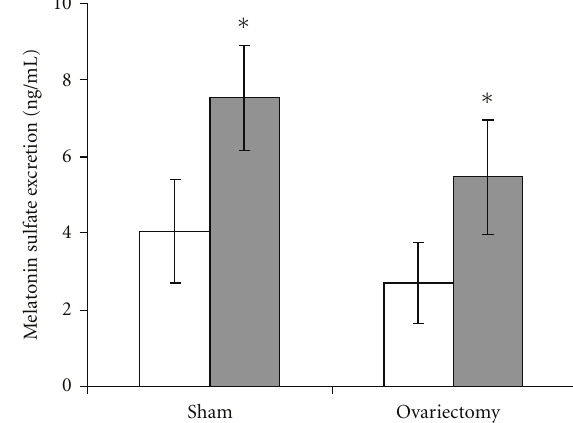
Figure 5: Urinary excretion of the major melatonin metabolite is increased by neonatal SSRI exposure independent of ovarian status. Mice were placed in metabolic cages for 24 hours and urinary excretion of melatonin sulfate was quantified by ELISA for samples from control (white bars) and SSRI-exposed mice (gray bars) that had undergone sham surgery or bilateral ovariectomy at least one month prior to collection. N = 5–9 mice from 5–7 litters per group; ∗ P = 0 . 034 versus control by ANOVA, P = 0 . 23 for ovariectomy versus sham